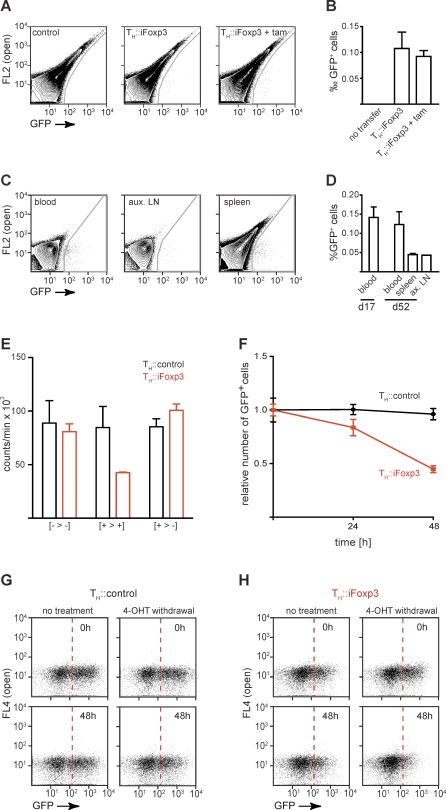
TH::iFoxp3 Cell Longevity(A) Representative FACS profiles of splenocytes purified from the indicated mice 52 d after transfer of 1 × 106 TH::iFoxp3 cells. tam, tamoxifen.(B) Summary of the frequency of GFP+ cells in the spleen 52 d after transfer (n = 3 in each case).(C) Representative FACS profiles of specified tissues 52 d after transfer of 2 × 106 TH::iFoxp3 cells (n = 4 in each case; for auxiliary lymph node [aux. LN], a pooled sample was analyzed).(D) Summary of the frequency of TH::iFoxp3 cells in the various tissues 17 and 52 d after transfer.(E–H) TH::iFoxp3 cell survival upon 4-OHT withdrawal (E). TH::control and TH::iFoxp3 were cultured in the continuous presence [+ > +] or absence [− >−] of 50 nM 4-OHT. In the case of [+ >−], 4-OHT was withdrawn for 72 h after an initial induction for 48 h, before their suppressive activity was measured. A total of 1 × 105 cells of the indicated populations were cocultured at a 1:1 ratio with 1 × 105 CD4+CD25− target cells in 96-well plates coated with anti-CD3ɛ [0.6 μg/ml]. The proliferation of the cells was measured after 72 h based on 3H-thymidine incorporation (n = 3 in each case). (F–H) TH::control and TH::iFoxp3 were cultured in the presence or absence of 4-OHT (50 nM) and anti-CD3ɛ (0.6 μg/ml). After 48 h, 4-OHT and anti-CD3ɛ was withdrawn. The viability of the cells was assessed by flow cytometry at 0 h, 24 h, and 48 h by measuring the coexpression of GFP.(F) Ratio of cells after 4-OHT withdrawal and cells that were cultured in the absence of 4-OHT from the start.(G and H) Representative FACS profiles of TH::control and TH::iFoxp3 cells. All error bars represent the SEM.